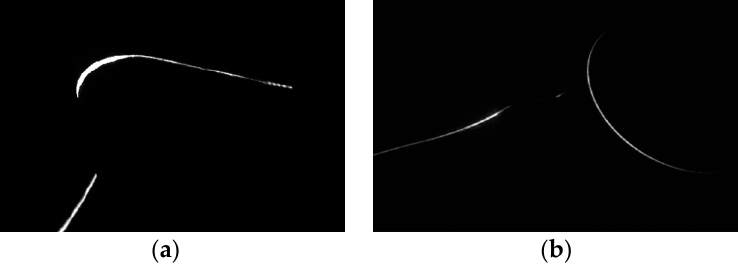
Figure 5. Image of the laser stripe. ( a ) Image of the wheel tread; ( b ) image of the axle of the wheelset.